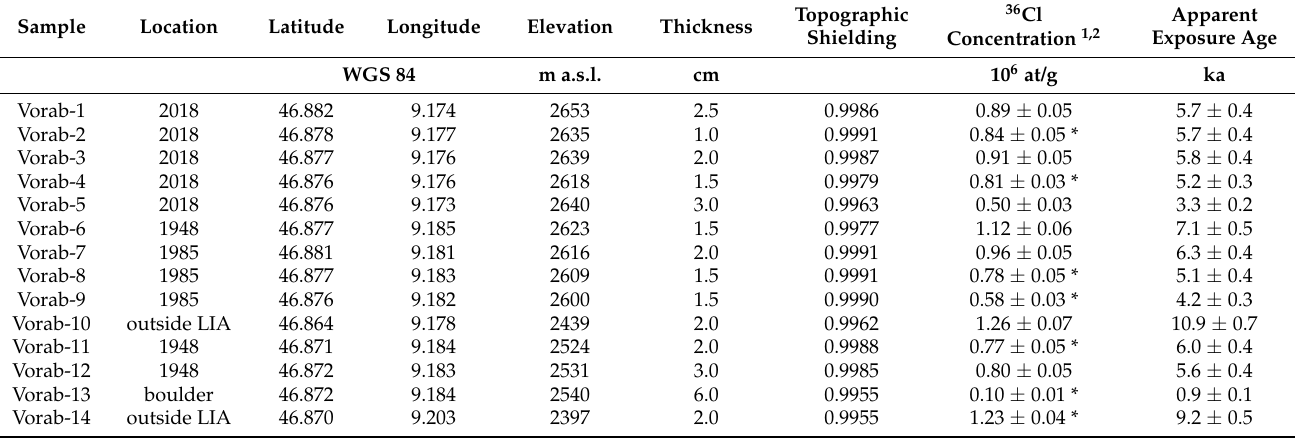
Table 1. Sample site information, AMS-measured 36 Cl concentrations and calculated apparent exposure ages. Sample Location